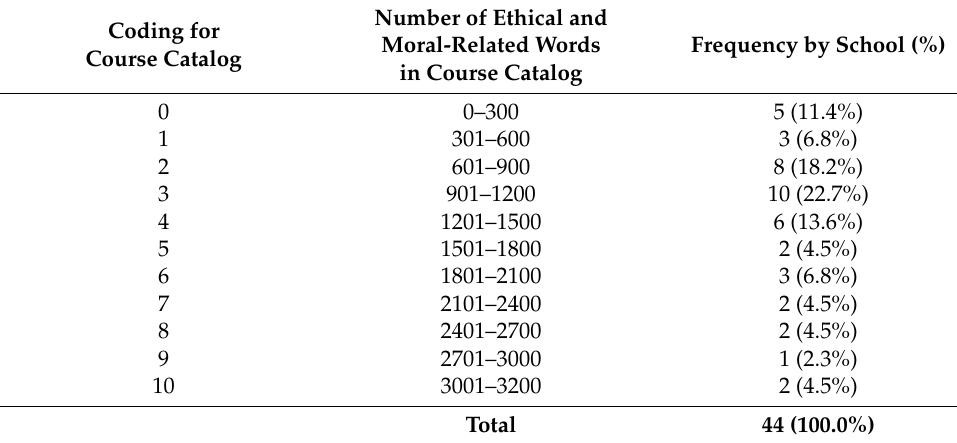
Table A4. Frequency of Morally Relevant Words in Course